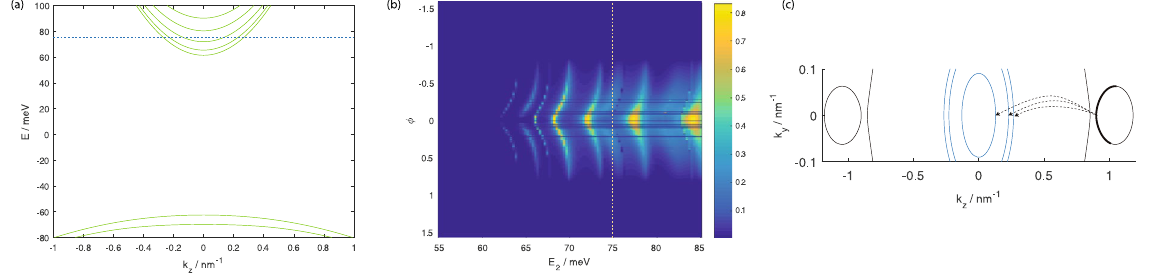
Figure 4. ( a ) shows dispersion relation of the model topologically trivial material obtained by setting ′ M = 60 meVnm 2 at k = 0. ( b ) shows transmission as a function of the angular coordinate ϕ along the positive y 0 k z Dirac ‘cone’ and E 2 in the central segment for a central segment of length 50 nm. ( c ) shows the central segment EEC at E 2 = 75 meV, and the source EEC. The horizontal dotted line in panel ( a ) and vertical dotted line in panel ( b ) denote the E 2 = 75 meV